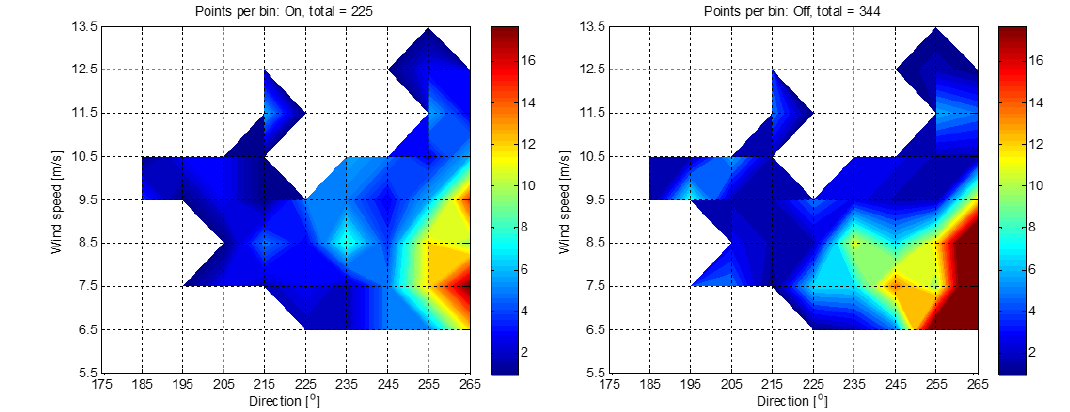
Figure 17. Numbers of points in each bin.